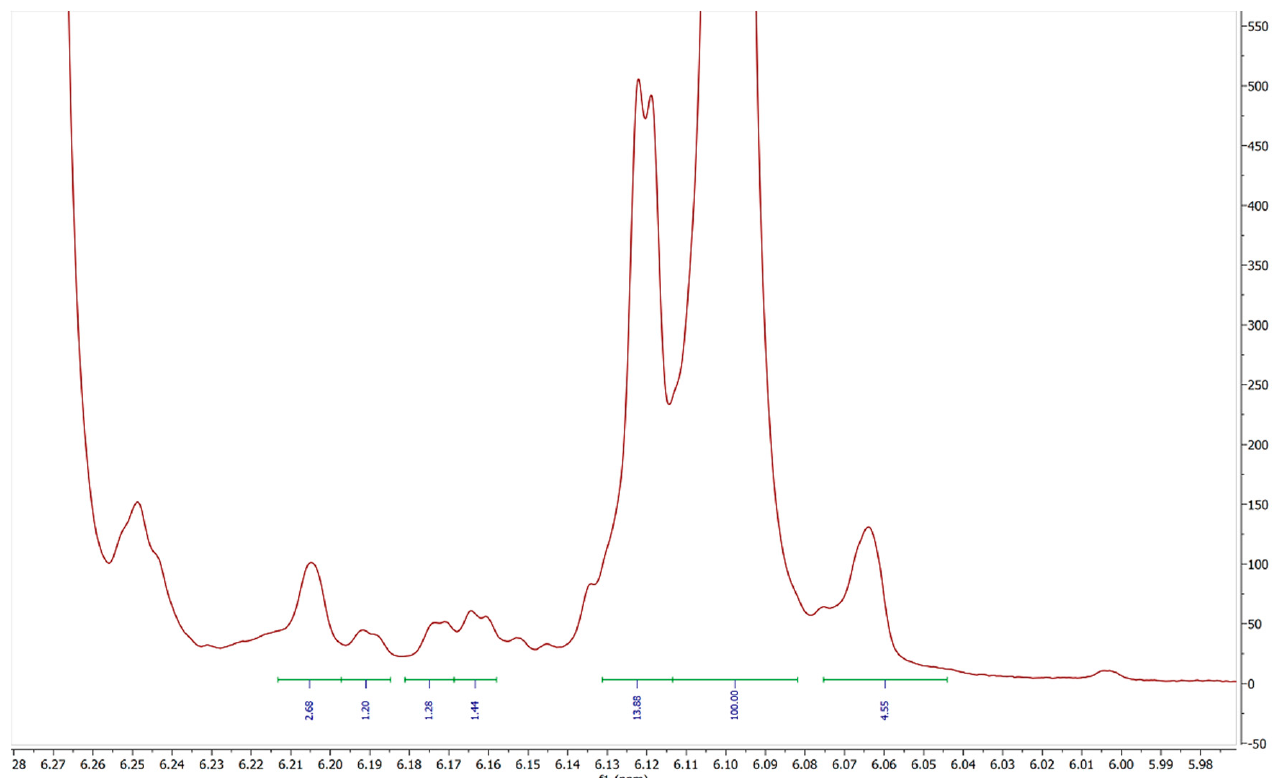
Figure 5. 400 MHz 1 H NMR spectrum of sample 3 from 5.97 to 6.28 ppm.